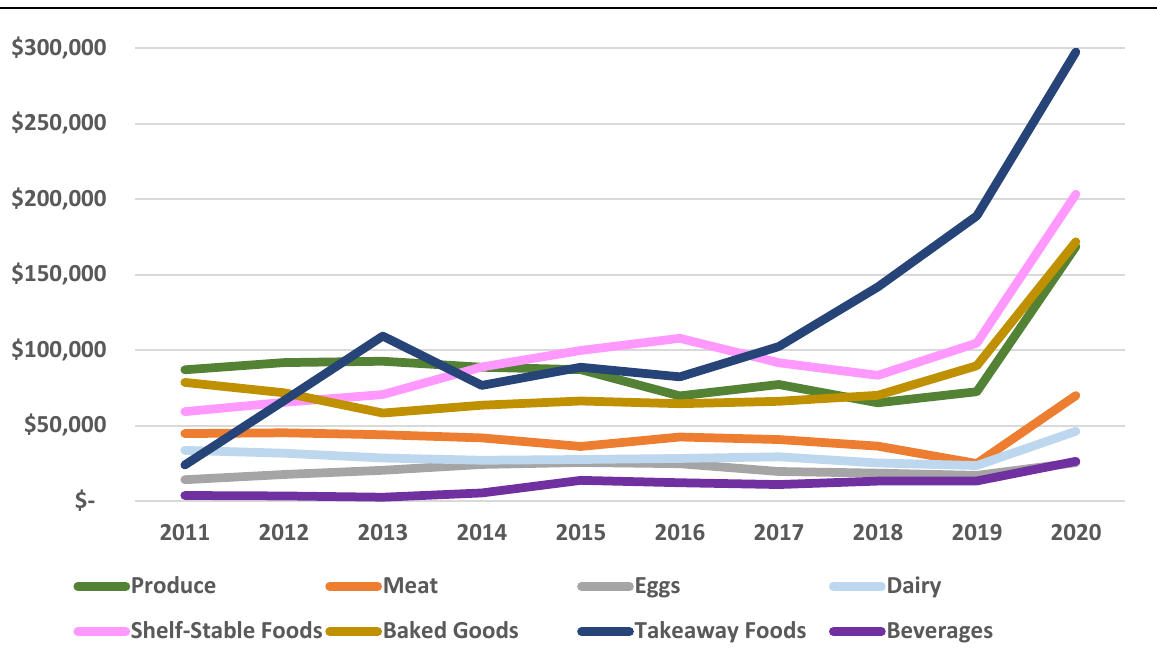
Figure 3. Annual Sales by Food Category, 2011 –